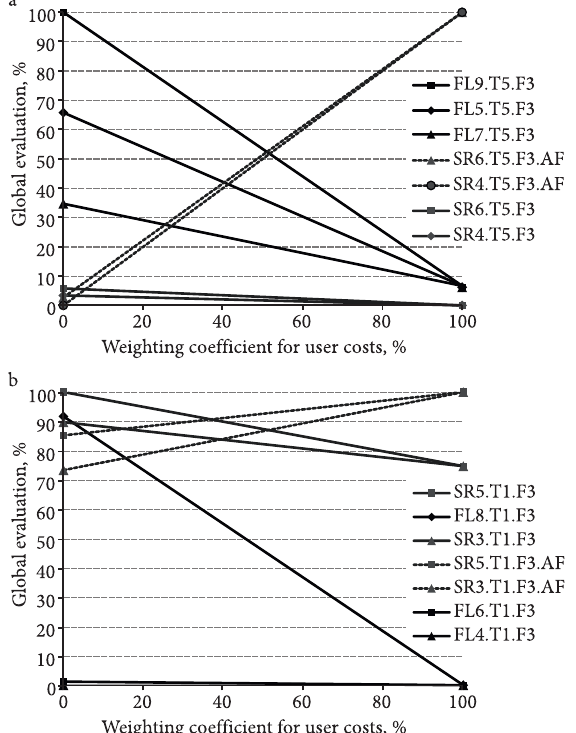
Fig. 4. Sensitivity analysis of the global evaluation in relation to the user costs: a – traffic T5; b – traffic T1